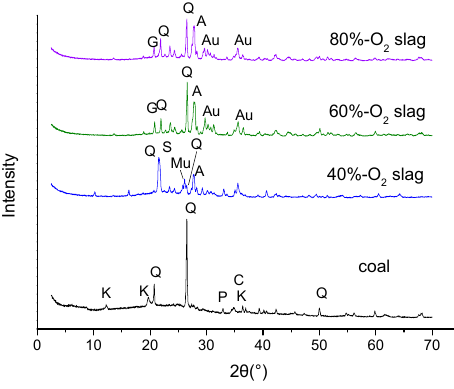
Figure 8. XRD patterns of coal and UCG slag. Q-Quartz; Py-Pyroxene; A-Anorthite; S-Sekaninaite; G-Gehlenite; P-Pyrite; C-Chlorite; K-Kaolinite; Mu-Mullite.